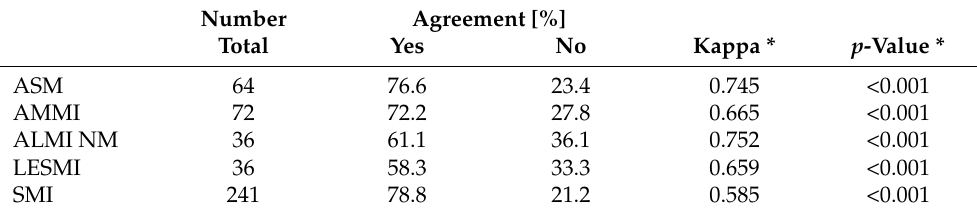
Table 4. Percent reliability of sarcopenia diagnosis between baseline and follow-up examination.